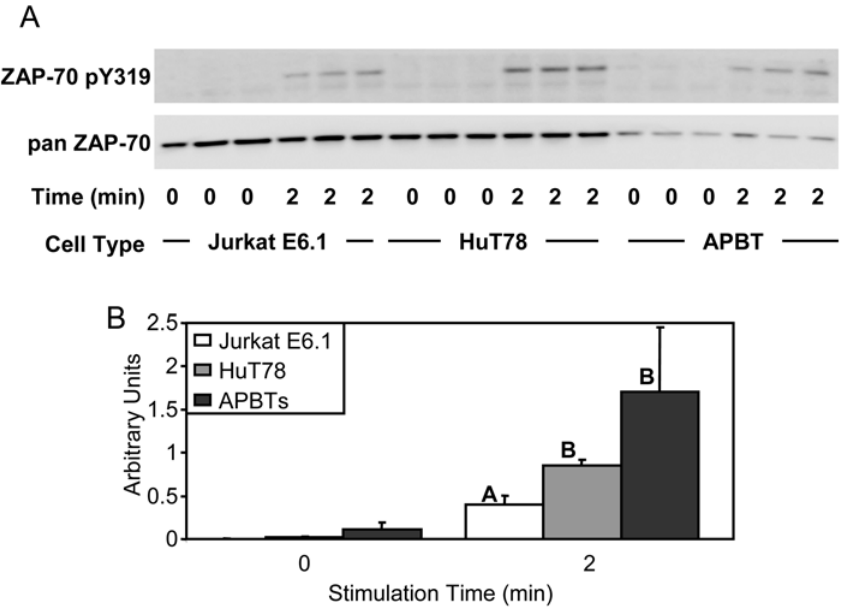
Figure 3. Jurkat E6.1 T cells exhibit decreased ZAP-70 Y319 phosphorylation compared to HuT78 T cells and APBTs. (A) Three samples of Jurkat E6.1 T cells, HuT78 T cells, and APBTs were stimulated and the cellular proteins were separated by SDS-PAGE. The site-specific phosphorylation and expression of ZAP-70 was assessed by immunoblotting using ZAP-70 pY319 (top) and pan-ZAP-70 (bottom) antibodies. (B) The immunoblots were analyzed by densitometry and the ratio of the intensity of the phosphospecific ZAP-70 band to the pan-ZAP-70 band for each cell line was averaged. Letters represents significant differences of p , 0.05.